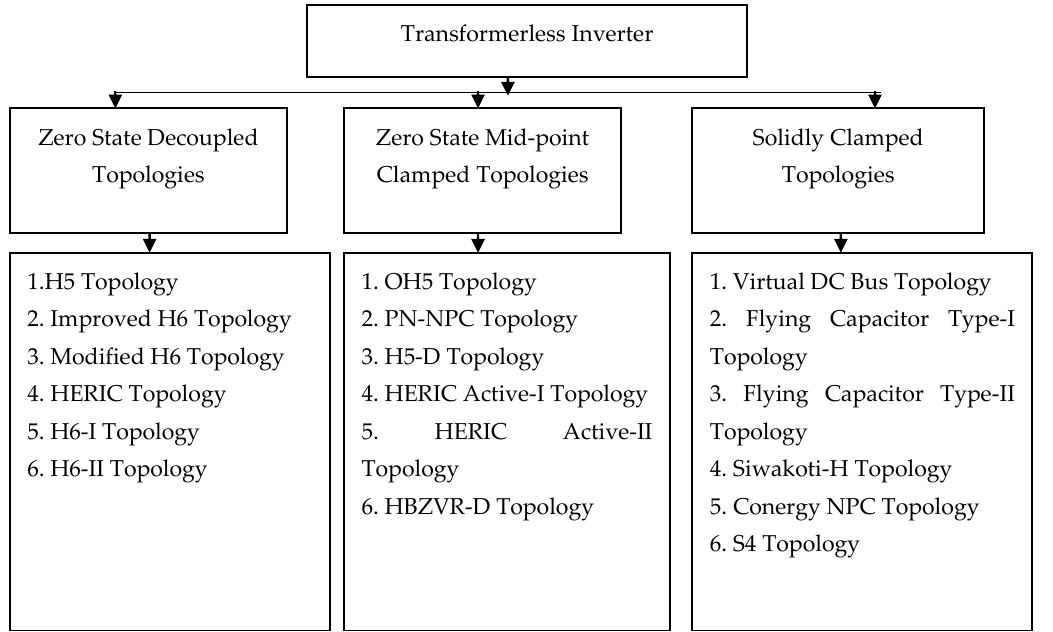
Figure 6. Classification of selected major single-phase transformerless inverter topologies. Table 3. Parameters for simulations and comparisons.